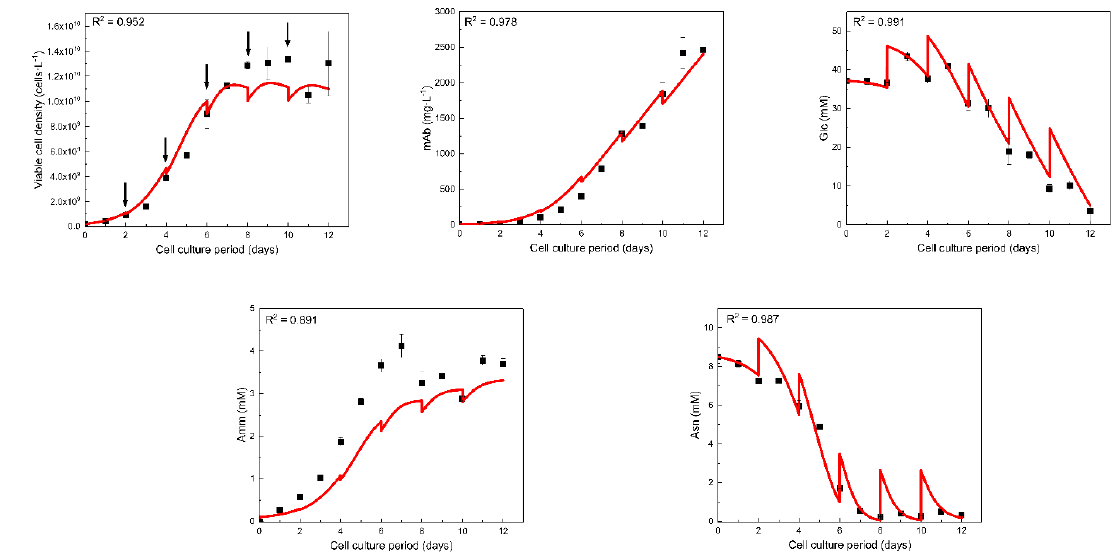
Figure 6. Model fitting (red line) to experimental data (black dots) for the calibrated model to GS46 cell line. The fitting of the model is also evaluated by the R 2 values that included in the graphs. The arrows indicate the days that the cell culture was supplemented with CD EfficientFeed TM C AGT TM Nutrient Supplement.